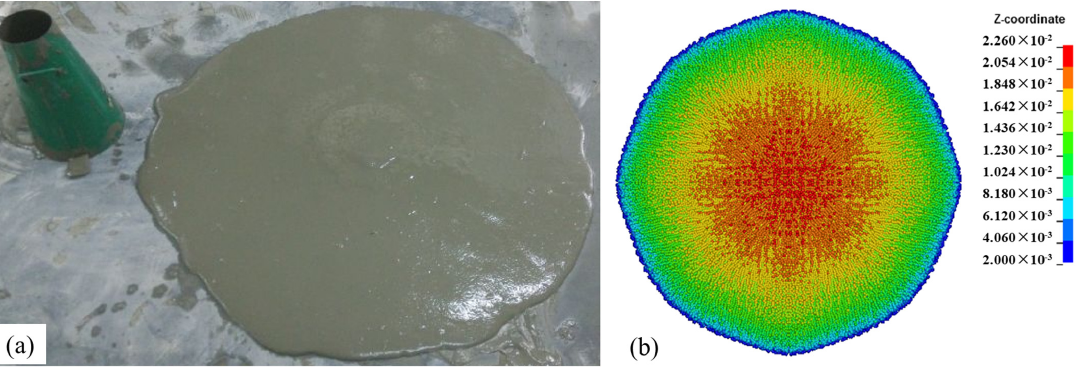
Figure A3. Final shape of the tailings slurry after the slump tests: ( a ) a photo of the laboratory test; ( b ) numerical result (Z-coordinate corresponds to the thickness of tailings slurry in meters).